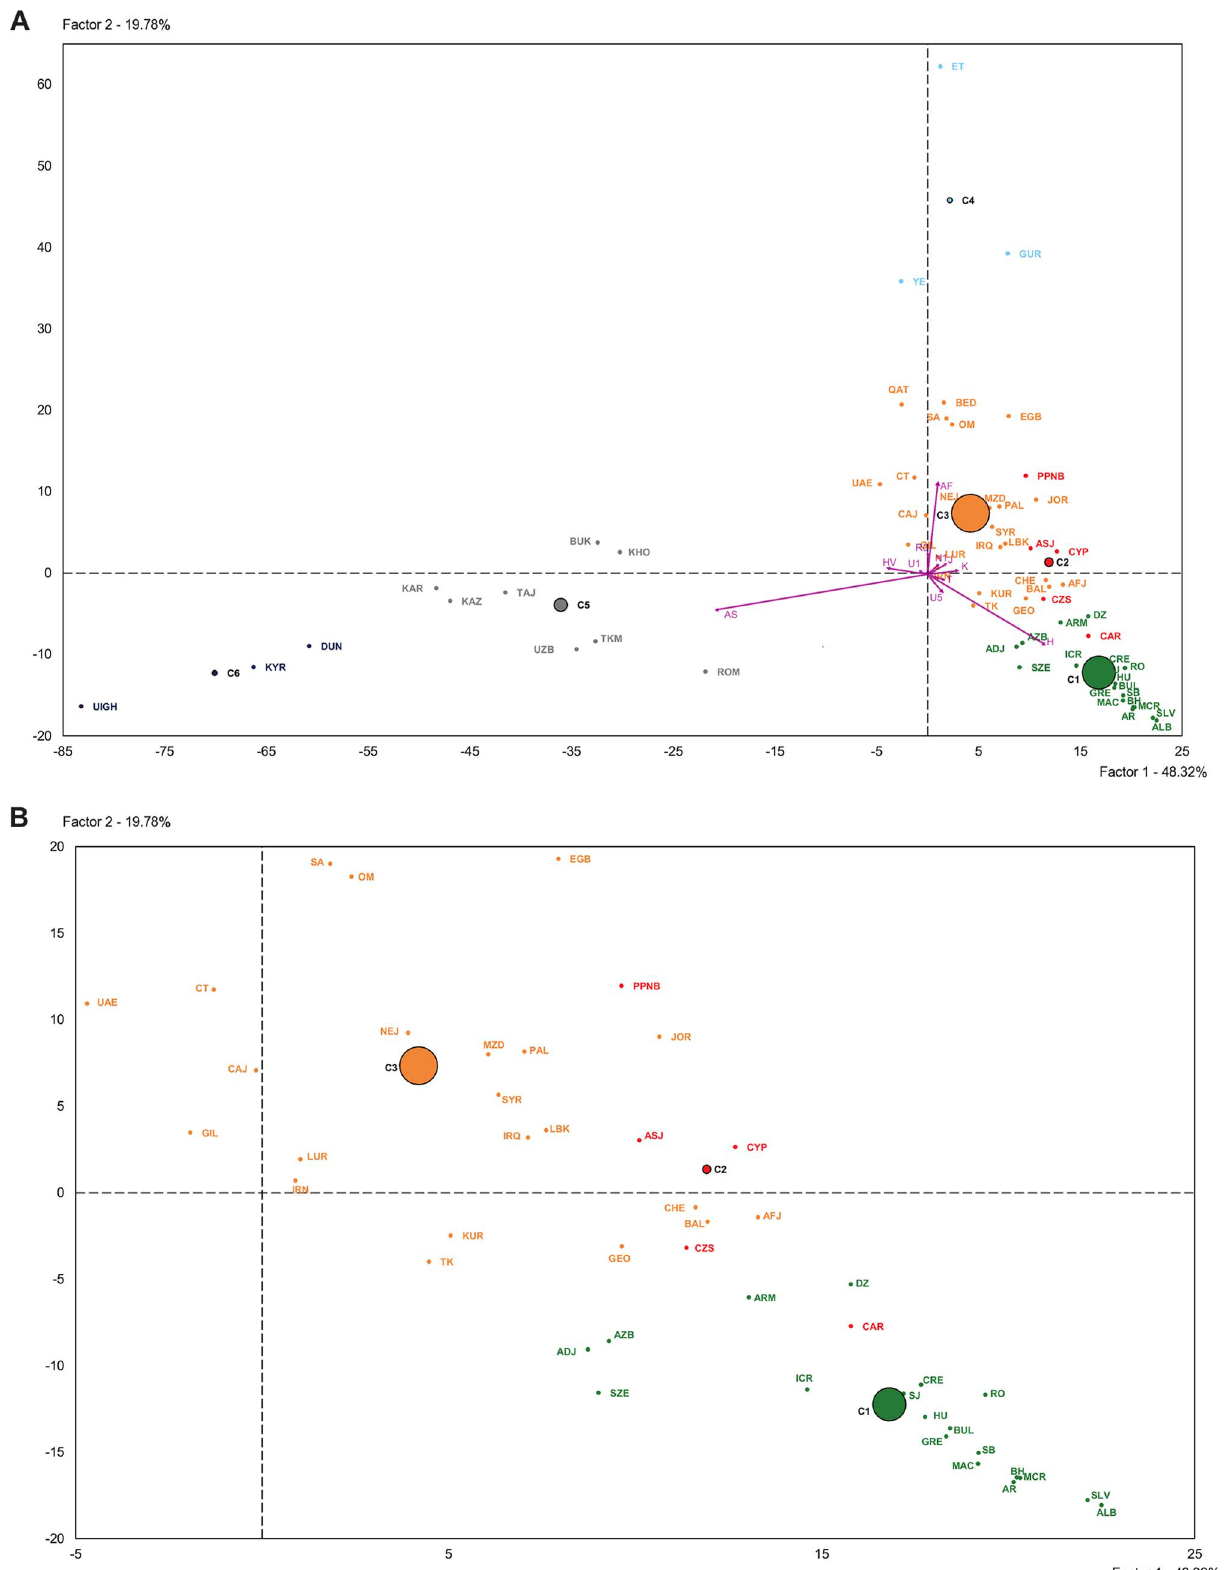
Figure 3. Plot of the two first principal components of the PCA-HCA performed using population haplogroup frequencies. (A) General plot. (B) Zoom plot of Clusters 1, 2 and 3. Population grouping in 6 clusters after HCA is indicated by colors: Cluster 1 (green), Cluster 2 (red), Cluster 3 (orange), Cluster 4 (light blue), Cluster 5 (grey), Cluster 6 (dark blue). Population labels are described in Table S4. doi:10.1371/journal.pgen.1004401.g003 PLOS Genetics | www.plosgenetics.org 8 June 2014 | Volume 10 | Issue 6 |